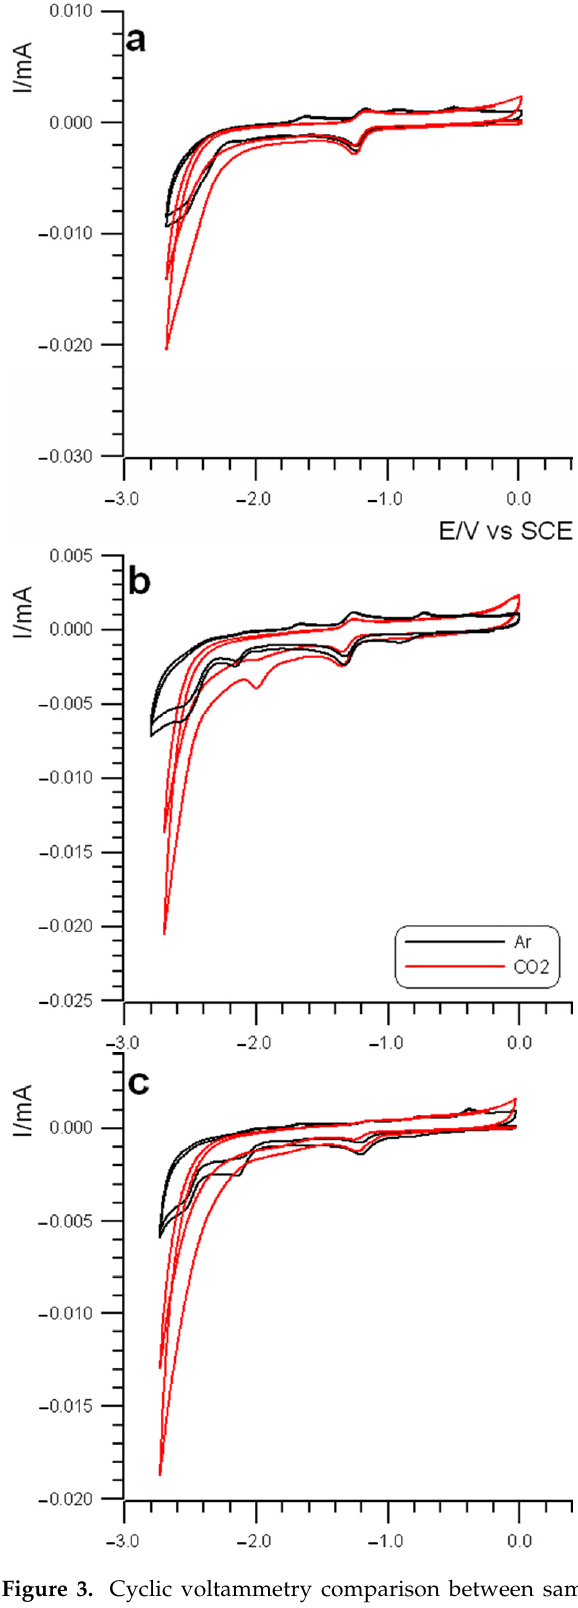
Figure 3. Cyclic voltammetry comparison between sample behavior in Ar (black) and in CO 2 (red) saturated solution of Mn-OMe ( a ), Mn-SMe ( b ), Mn-SPh ( c ) in DMF. Working electrode: GC (7.85 × 10 − 3 cm 2 ); reference electrode: SCE; scan rate: 0.4 V/s; T= 298 K.